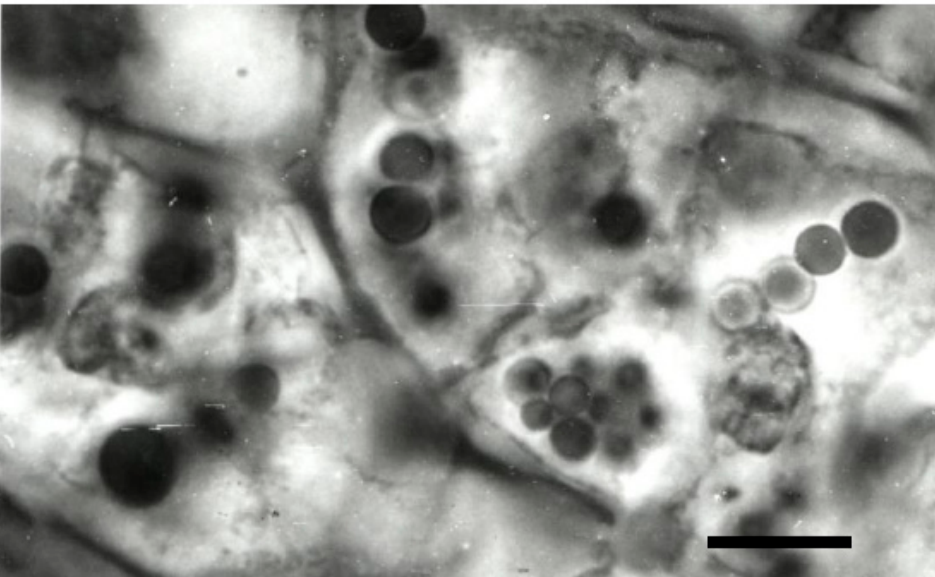
Figure 4. Histological analysis of slide images taken for callus cells of S. podophyllum . The small cells in the vicinity of the organogenetic areas present many starch inclusions (magnification × 45,000, bar = 10 µm).